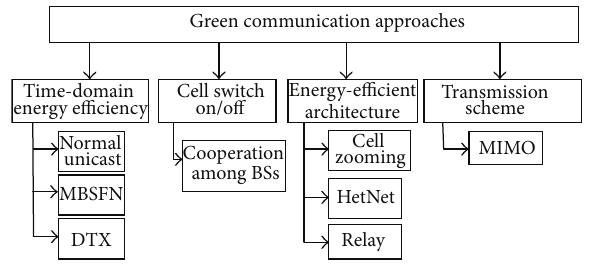
Figure 5: Classifications of energy-saving